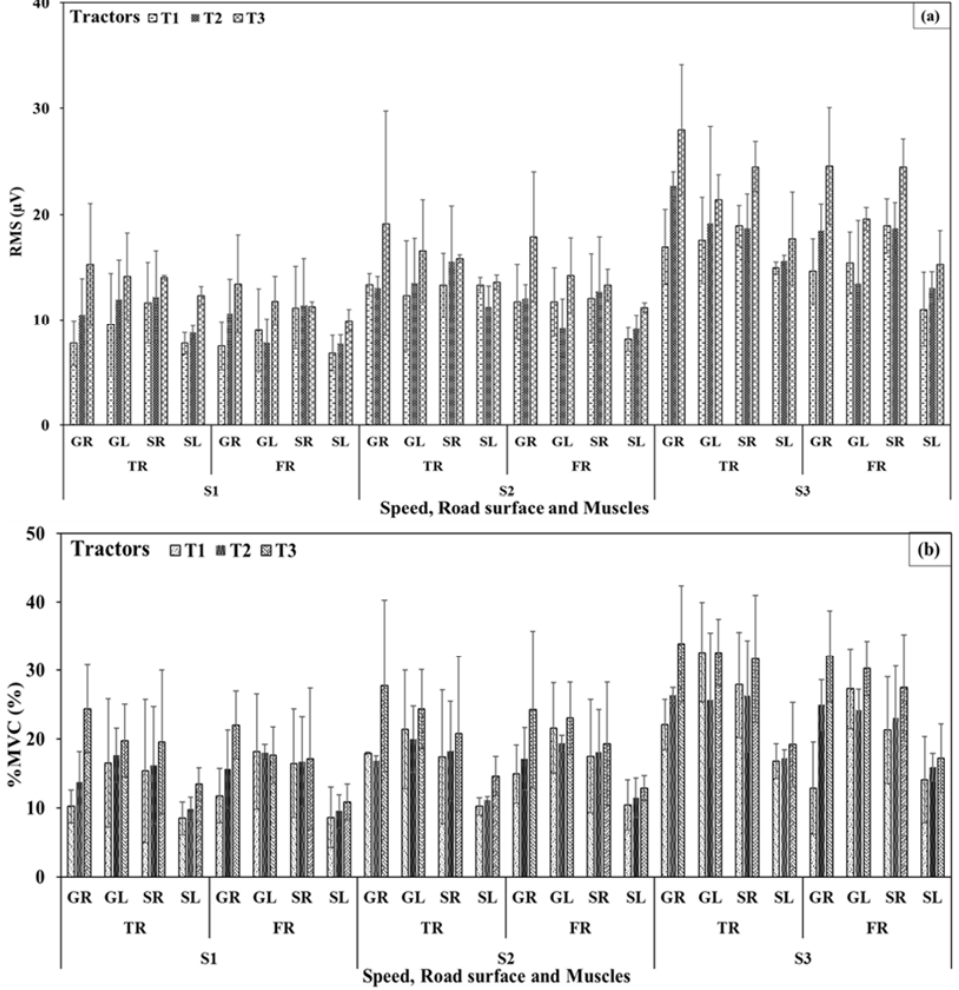
Figure 8. Electromyography ( a ) root mean square and ( b ) %maximum volumetric contraction. TR—Tarmacadam road surface, FR—Farm road surface; C—Clutch, B—Brakes. Further details are pre-